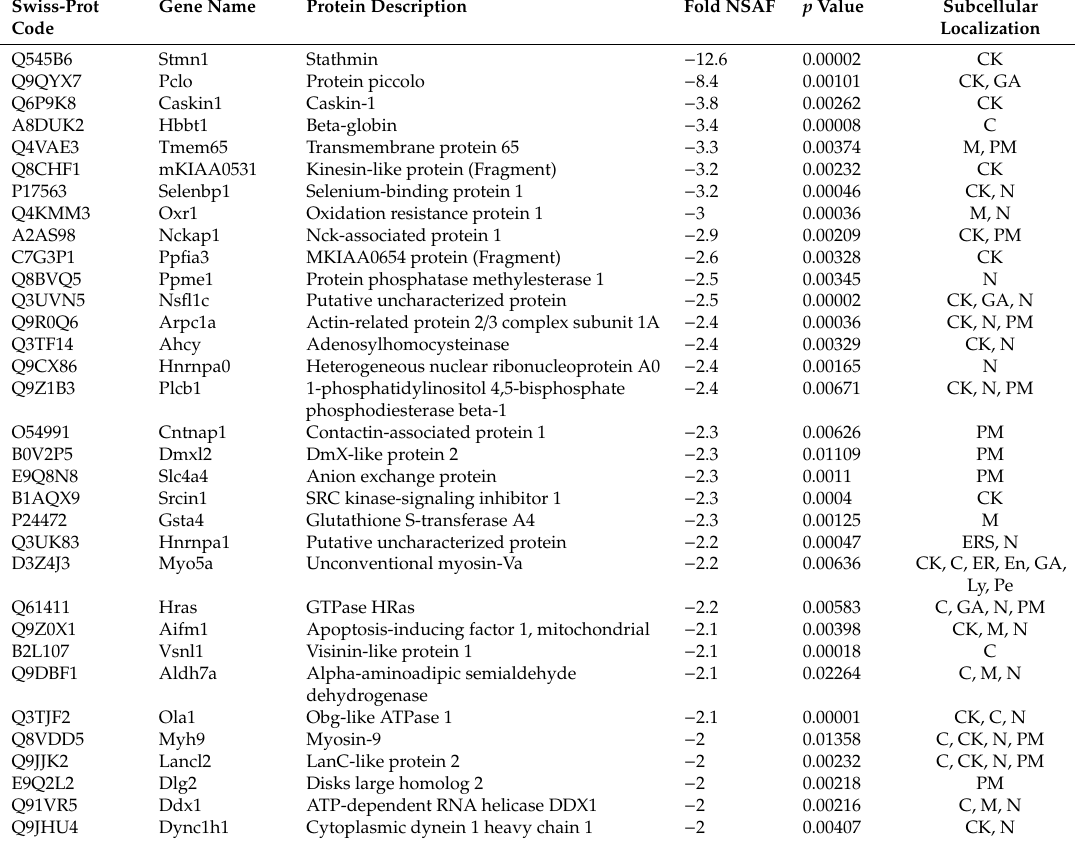
Table 1. Dysregulated proteins in NAGLU − / − mouse brains compared to